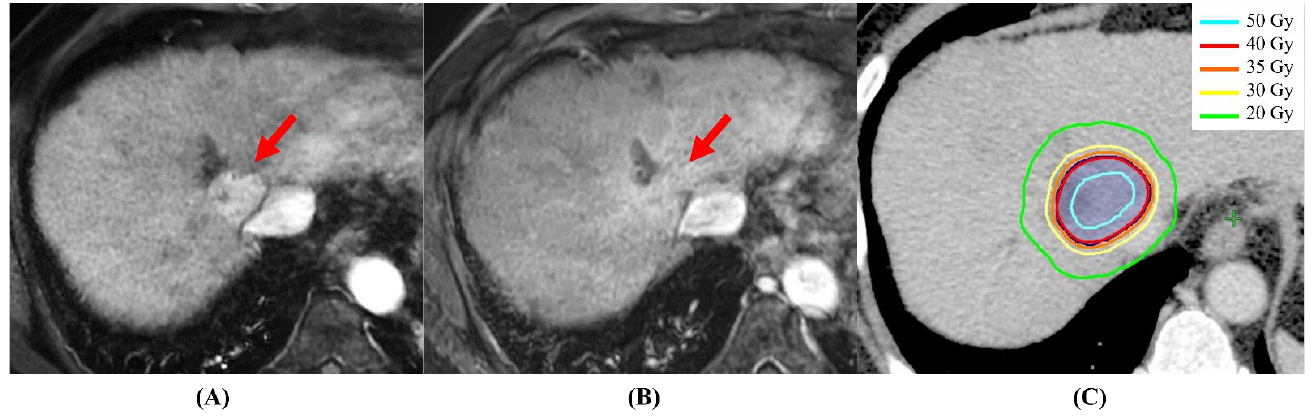
Figure 1. A typical case of complete response at 3.5 months after the completion of SBRT. ( A ) Dynamic MRI appearance (arterial phase) before SBRT; the early arterial enhancement is obvious (red arrow). ( B ) Dynamic MRI appearance (arterial phase) after 3.5 months; the early arterial enhancement has disappeared (red arrow). ( C ) Dose distribution of SBRT: the prescribed dose of 40 Gy covered 95% of PTV with 125% maximum dose of 40 Gy (80% isodose) in 4 fractions.